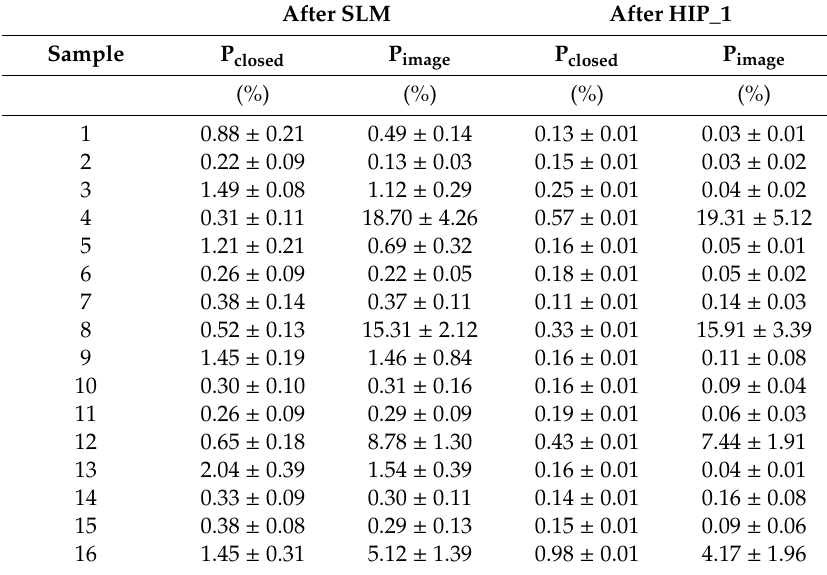
Figure 14. ( a ) OM image of sample 2; ( b ) OM image of sample 5; ( c ) OM image of sample 13; ( d ) BSEM image of sample 4. All samples are after the HIP_1 process and are in a polished state. Table 4. Determined porosity levels in the samples after SLM and SLM + HIP_1 (porosity of HIP samples is determined on the basis of one measurement of a rectangular sample).